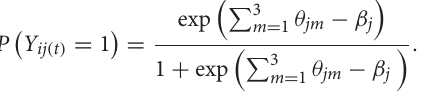
TABLE 2 | Area Under ROC curve (AUROC) for a standard ERS and